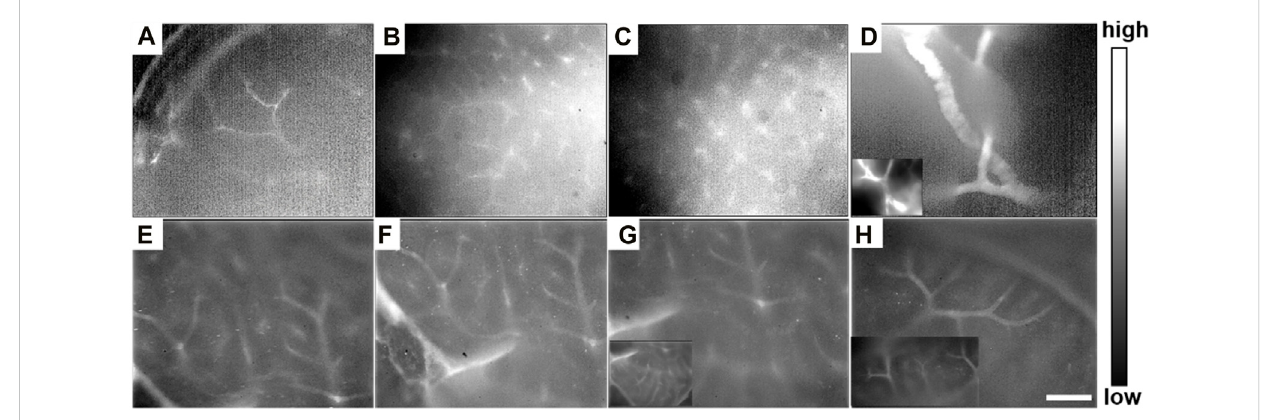
FIGURE 9 (A – H) Invitro NIR-II fl uorescence microscopicimagesofintrahepaticangiography post-injectionofICG under×25 objective, with an 808 nm laser